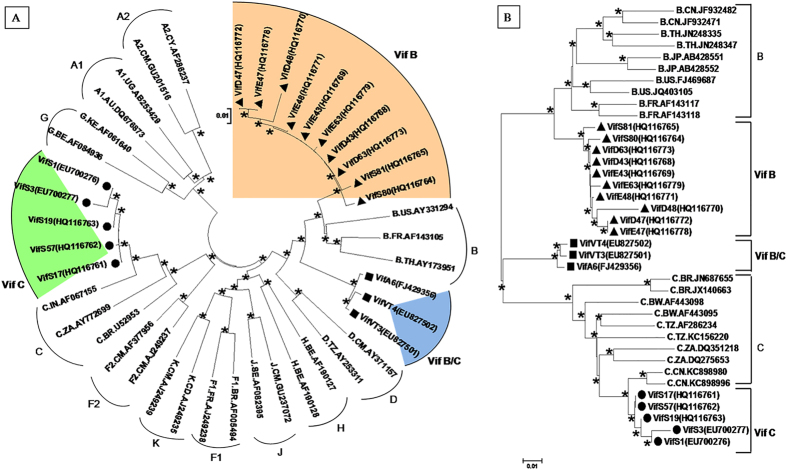
HIV-1 subtyping of Vif variants.(A) Phylogenetic tree of unique Vif variants with M (A to K including A1, A2, F1, and F2). (B) Phylogenetic tree of unique Vif variants with global subtype Vif B and Vif C reference sequences. Each reference sequence was labelled with subtype, followed by the country of isolation and accession number. Filled triangles represent B variants, filled circles represent C variants and filled rectangles represent B/C recombinants. The bootstrap probability (>60%, 1,000 replicates) was indicated with an asterisk (*) at the corresponding nodes of the tree and the scale bar represents the selection distance of 0.01 nucleotides per position in the sequence.